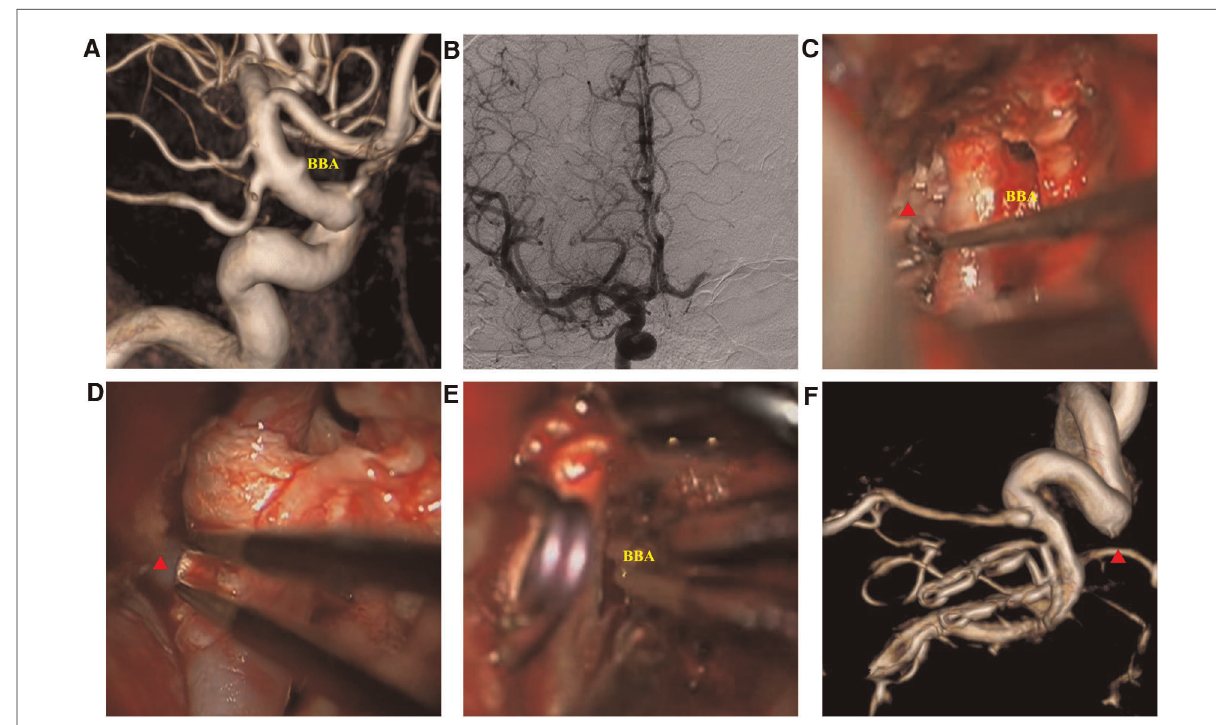
FIGURE 3 Intraoperatively ruptured blood blister-like aneurysm (BBA) images. ( A ) three-dimension digital subtraction angiography showed the BBA; ( B ) Matas test showing adequate compensation; ( C ) microscopic view showing the BBA and surrounding structures; ( D ) Y-shaped fascia preposition, posterior communicating artery (red triangle) crossing the fascia valves; ( E ) BBA neck avulsion; ( F ) DSA 14 days after the surgery revealing slight stenosis of the internal carotid